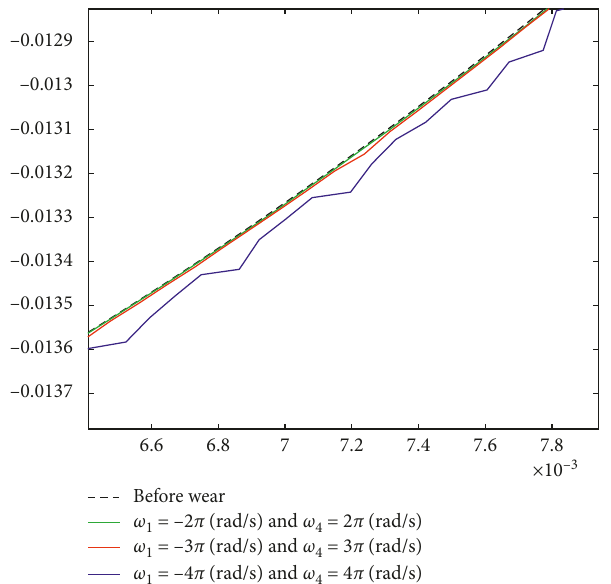
Figure 39: Local enlarged drawing of bearing surface of joint B .